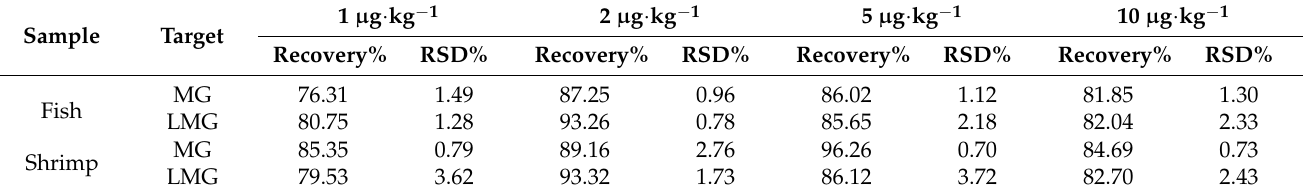
Table 2. Results of the recovery and accuracy evaluation experiments in spiked